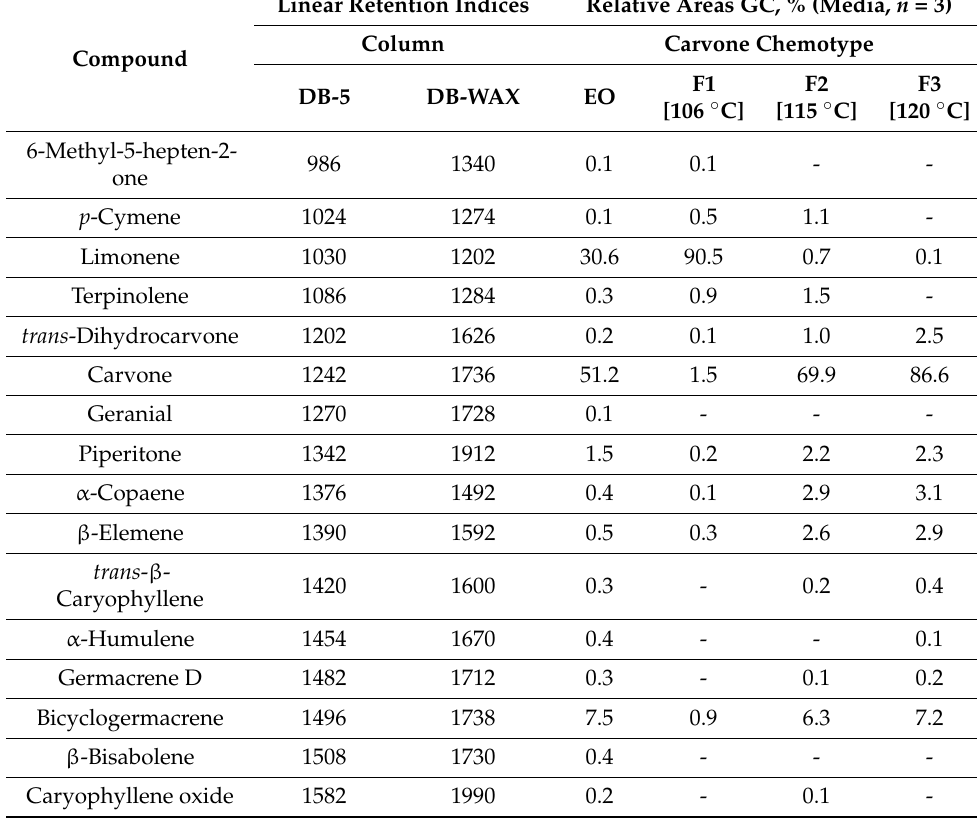
Table 2. Main compounds present in the essential oils and their fractions obtained from Lippia alba (carvone chemotype). Taken and adapted with permission from Quimbaya et al.